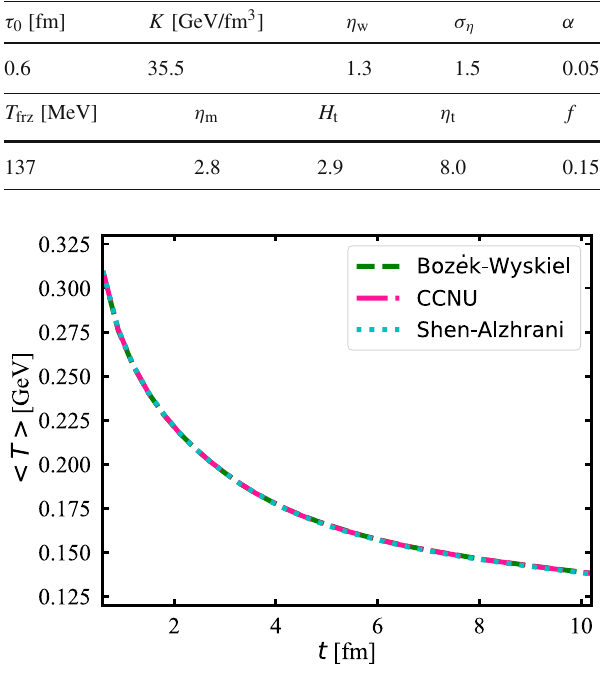
Fig. 7 Time evolution of the average temperature (cid:8) T (cid:9) , compared between three different initial condition setups